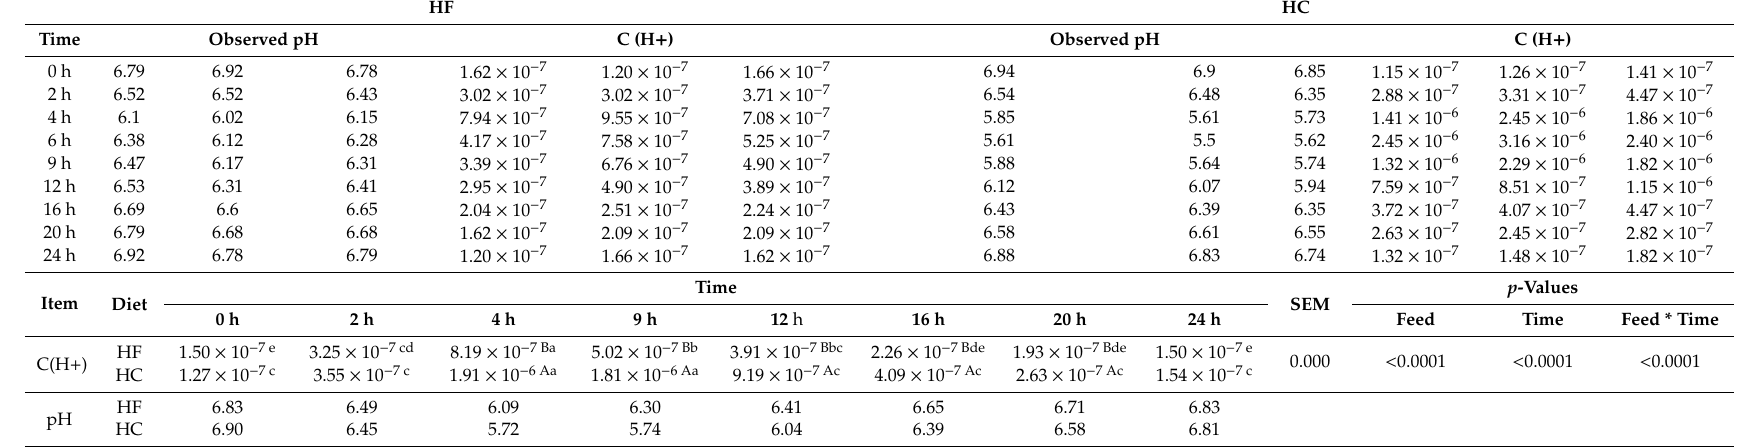
Table 1. Rumen pH over the course of a feeding cycle in dairy cows receiving two diets: high-forage (HF) and high-concentrate